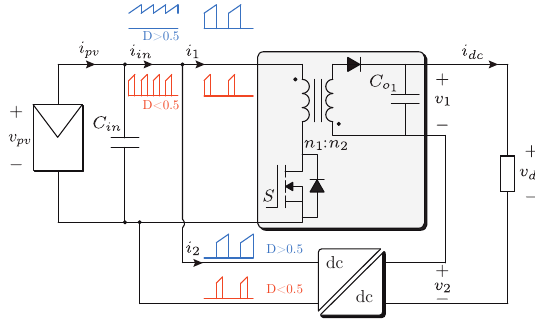
Figure 1. Traditional interleaved configuration using a Flyback